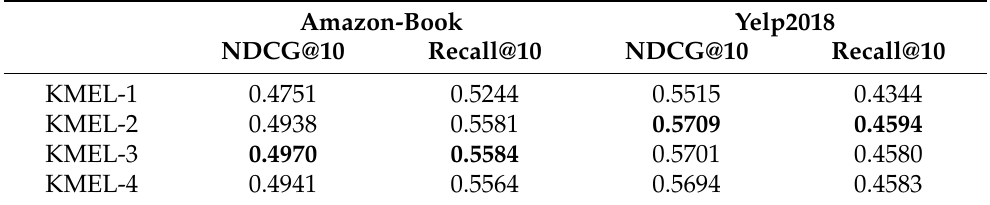
Table 3. Performance of the proposed KMEL with varying propagation depth by NDCG@10 and